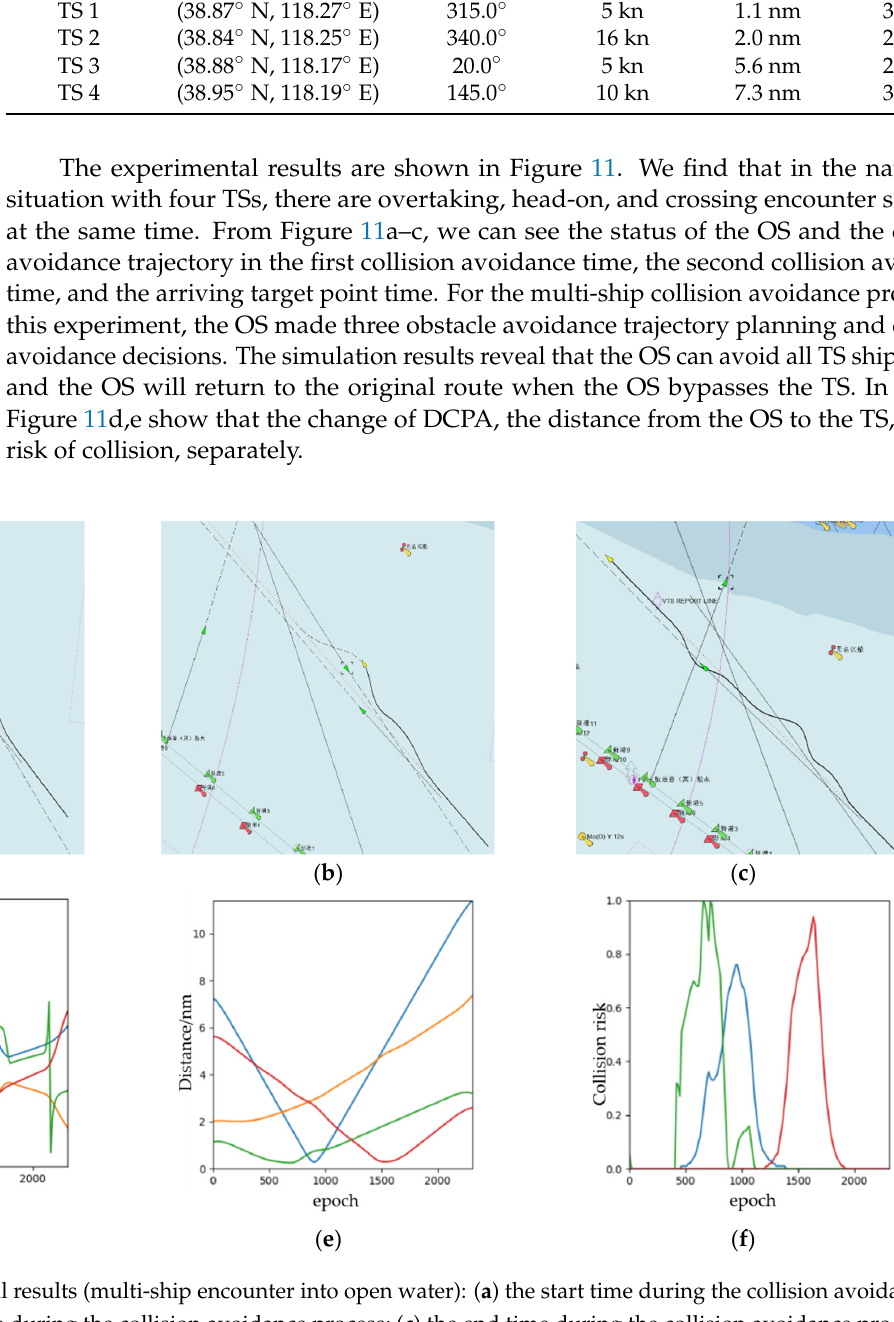
Table 6. Initial information (multi-ship encounter into open water).